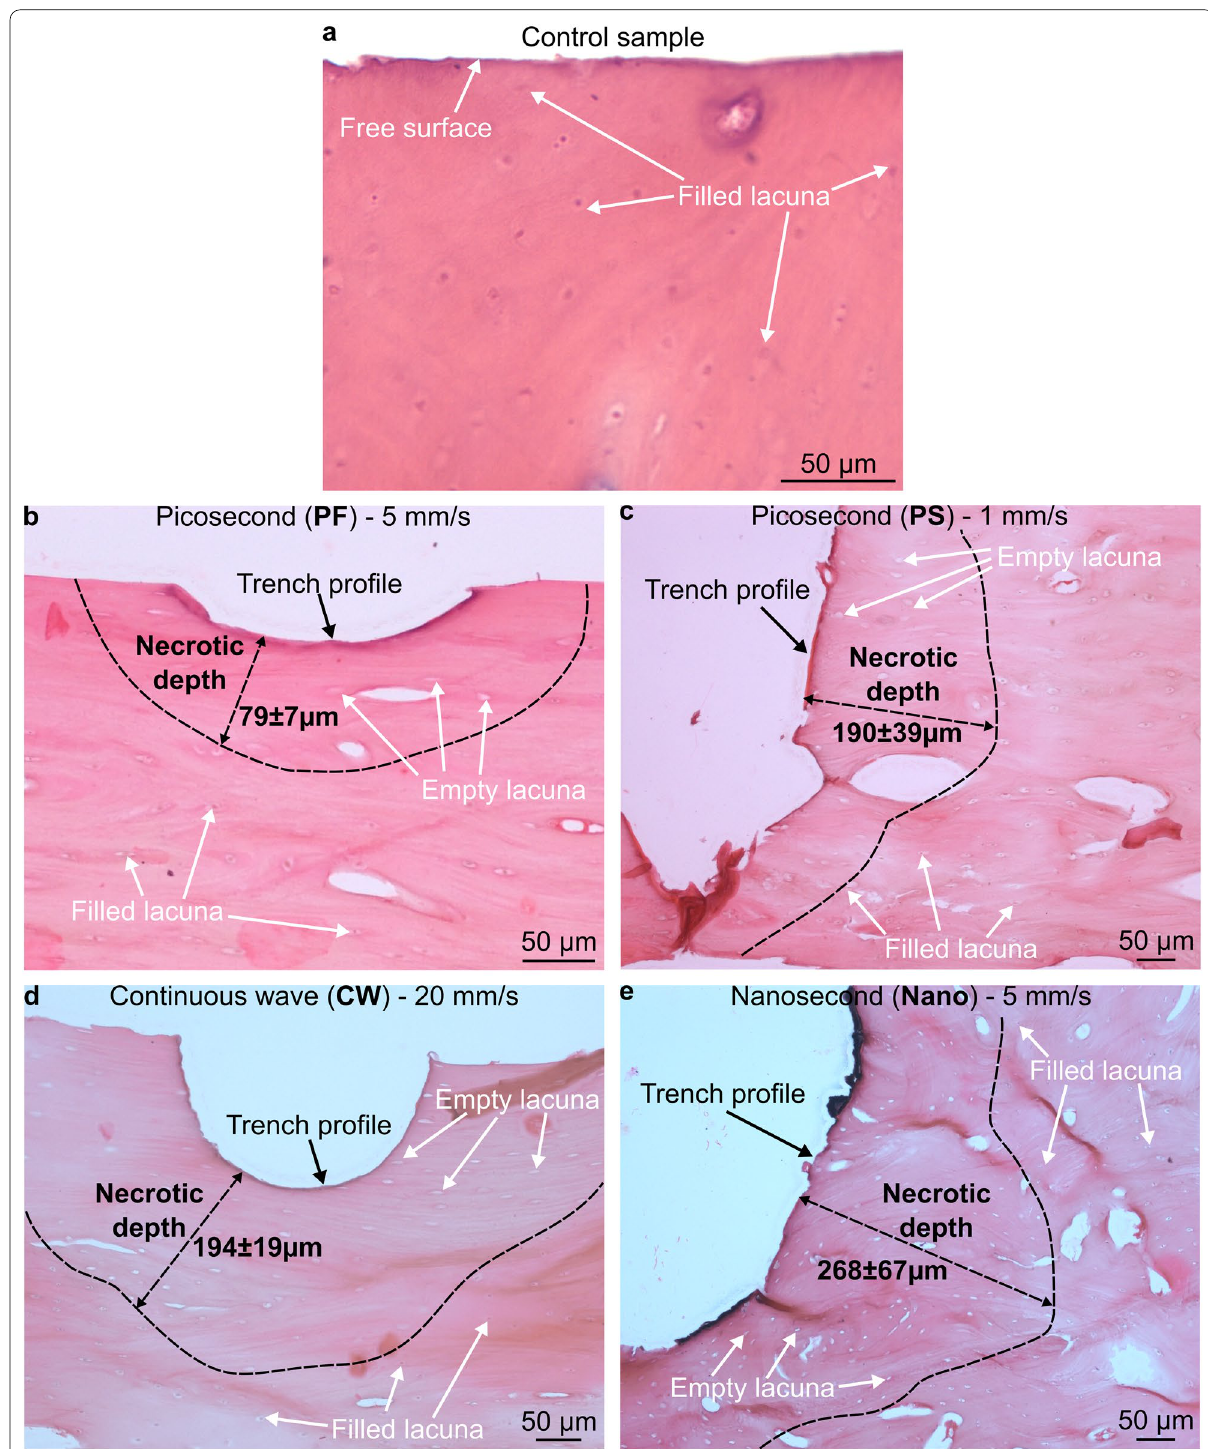
Figure 9 (See legend on previous